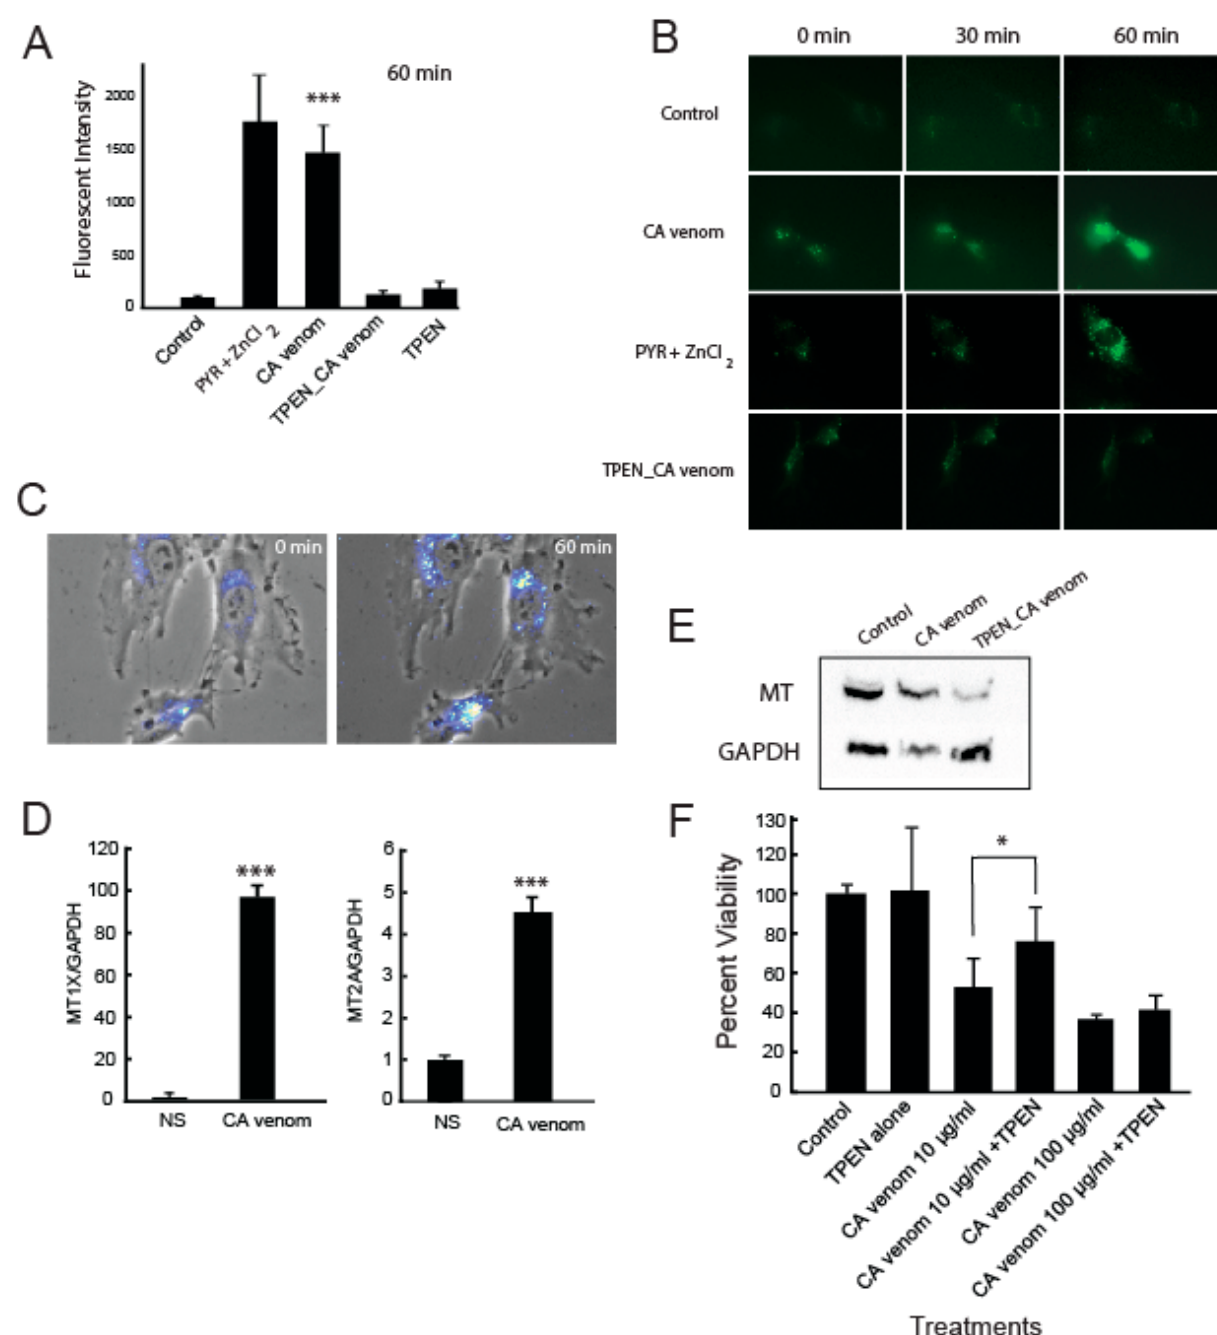
Figure 2. Zinc trafficking in HUVEC during CA venom stimulation. ( A ) Fluorescent microscopy analysis. Cells were stimulated with CA venom, pyrithione-zinc, TPEN_CA venom or TPEN alone for 1 h. *** p < 0.001 vs. non-stimulated control (n = 10–15 cells per experimental group). ( B ) Representative fluorescent micrograph time course of HUVEC loaded with FluoZin-3AM treated with PYR/ZnCl 2 , TPEN (preincubation) then CA venom or CA venom alone (400×). ( C ) Phase contrast and fluozin-3AM fluorescent composite micrographs of HUVEC stimulated with CA venom after 60 min period. ( D ) qPCR of MT1X and MT2A gene expression after 3 h stimulation with CA venom *** p < 0.001 (n = 3). ( E ) Western blot. Metallothionein (MT) protein expression stimulated with CA venom or TPEN (preincubated) then CA venom for 8 h. ( F ) MTS cytotoxicity assay. Cell treated with CA venom alone (10 and 100 µ g/mL), TPEN alone 3 µ M or pretreated with 3 µ M TPEN, then stimulated with CA venom (10 or 100 µ g/mL) or 3 h. * p < 0.05 vs. CA venom 10 µ